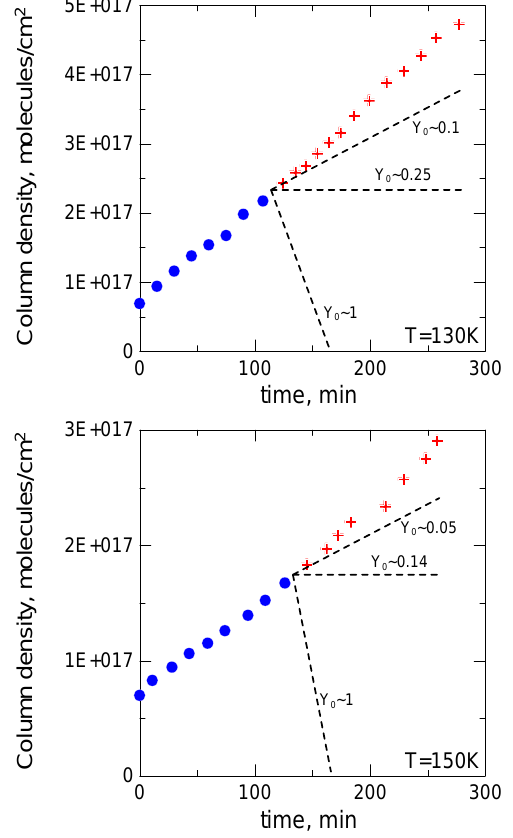
Fig. 3. Time evolution of column density at different temperatures before irradiation (blue points) and after switching on VUV lamp (red crosses). The dashed black lines indicate asymptotic trends of the column density corresponding to different theoretical values of absolute photodesorption yield (in moleculephoton − 1